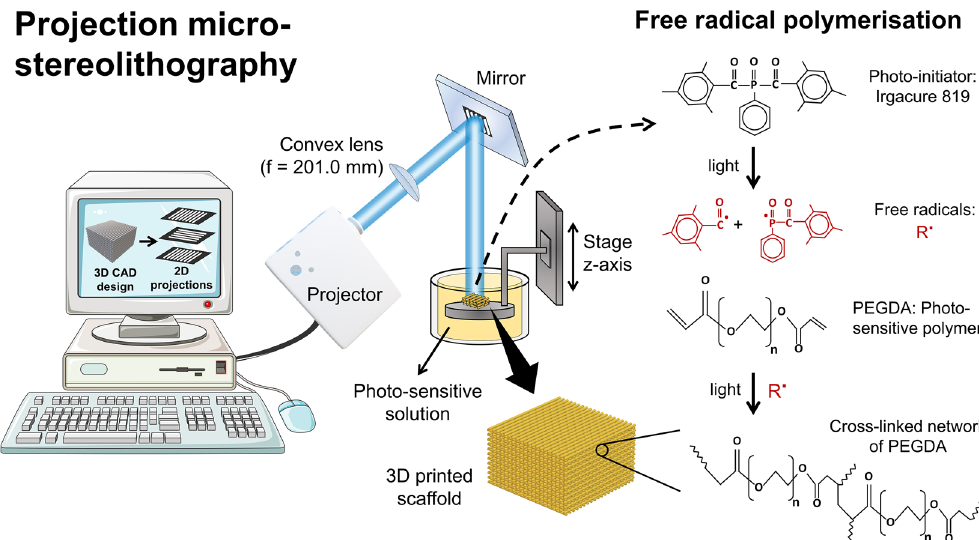
Figure 1. Scheme of the custom-built 3D printing micro-stereolithography setup. The scaffold is designed using AutoCAD and the 3D geometry is virtually sliced into 2D projections/impressions that act as digital